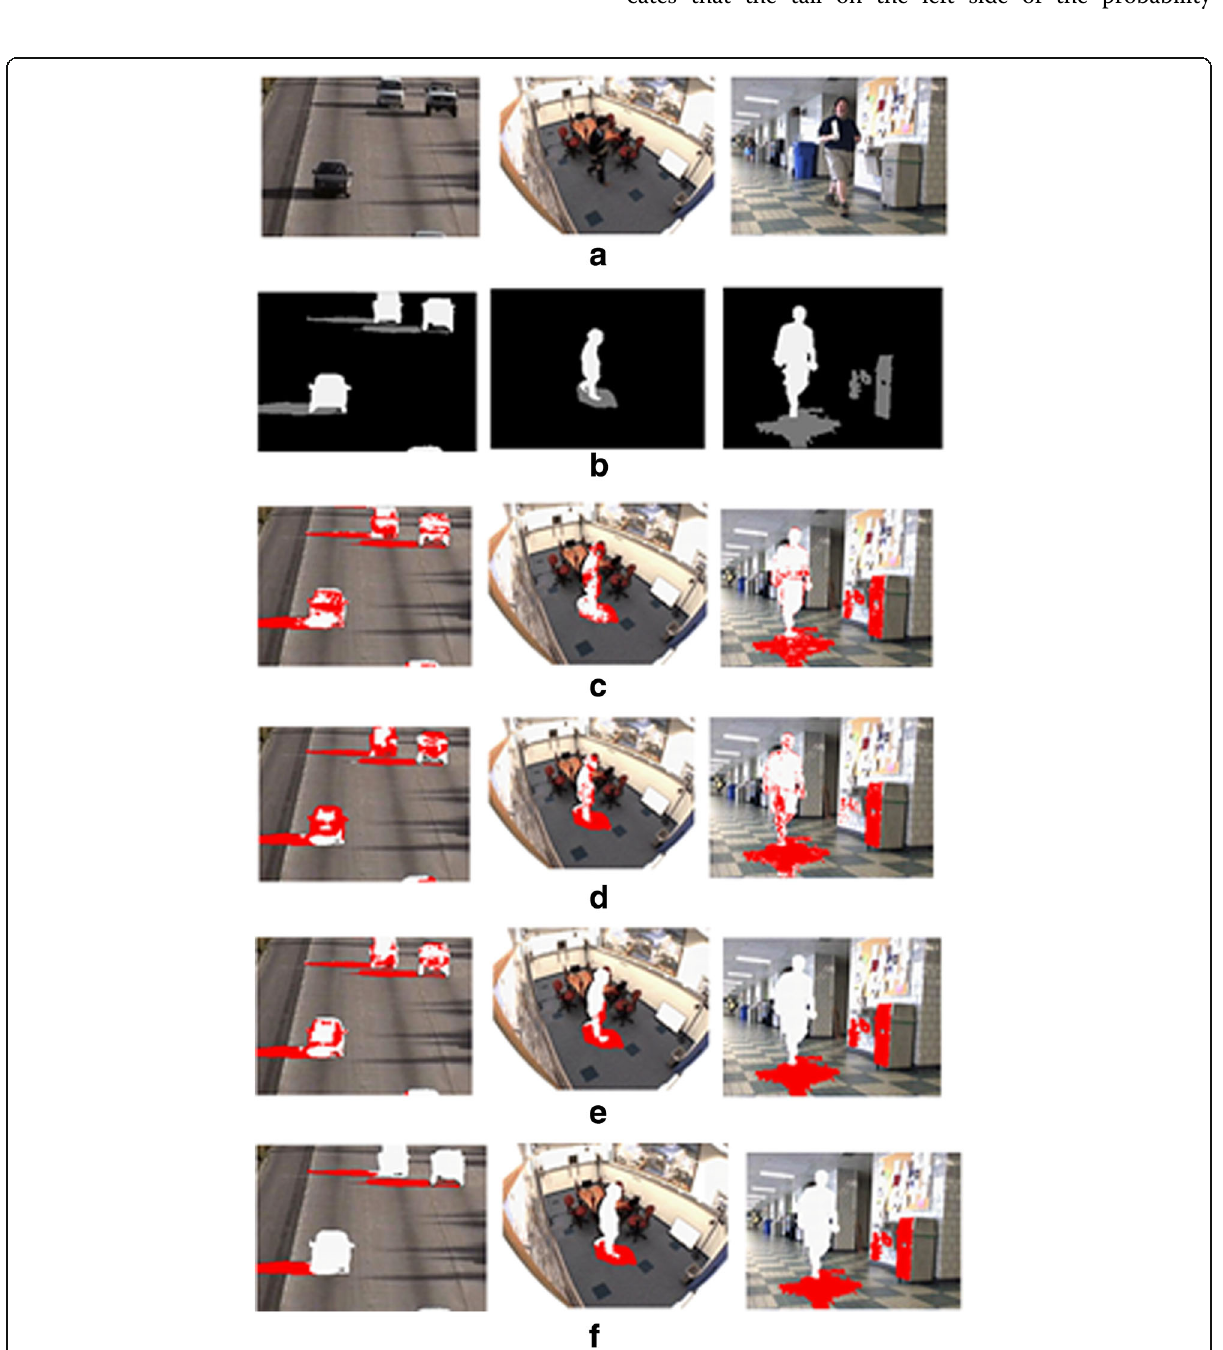
Fig. 3 Visualized comparison results of the proposed method with others. a Input frame from Highway I, Intelligent Room, and Hallway. b Ground truths of the respective frames from video sequence. c Results of Sanin et al. [12]. d Results of Cucchiara et al. [7]. e Results of Guan et al. [26]. f Results of the proposed